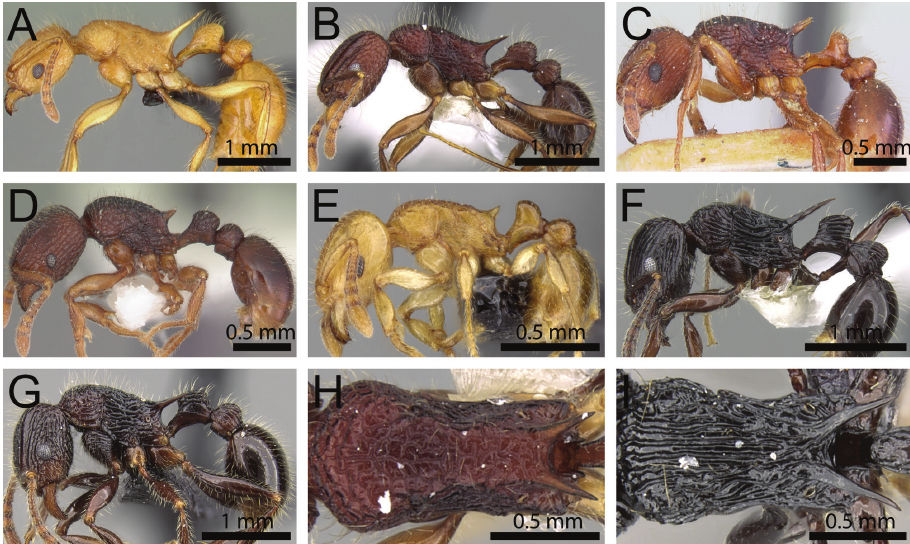
Figure 20. Mesosoma and waist segments in profile; mesosoma in dorsal view. A T. kelleri (CASENT0467063) B, H T. ankarana (CASENT0247543) C T. steinheili (CASENT0101258) D T. ranarum (CASENT0102392) E T. rala (CASENT0162115) F T. ambanizana (CASENT0189238) G T. nazgul (CASENT0028625) I T. smaug (CASENT0121244).